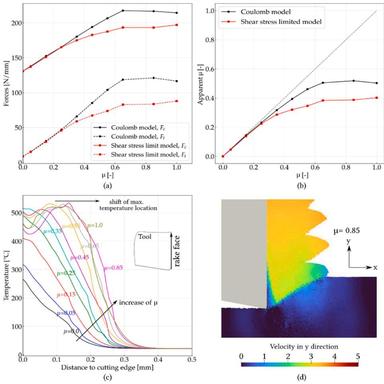
Influence of implemented µ on simulated (a) process forces (Classic Coulomb and shear stress limited Coulomb models), (b) apparent µ on the rake face and (c) rake face temperature, (d) restricted material flow around the cutting edge, Coulomb friction law is implemented.